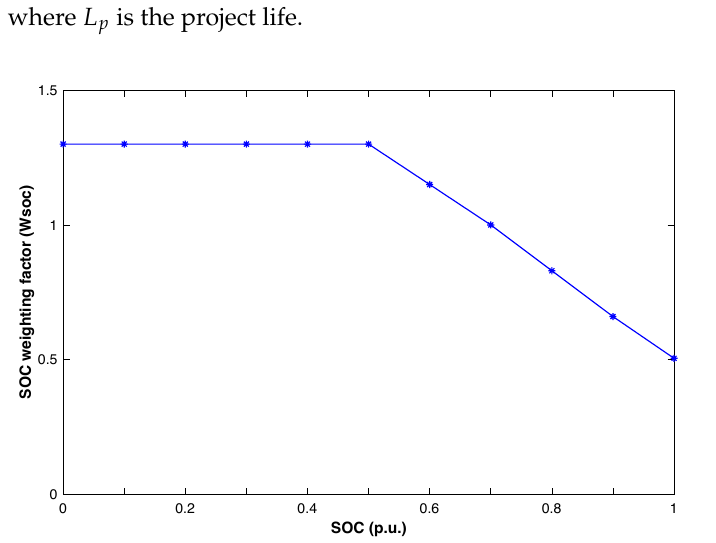
Figure 3. The relationship between SOC and the SOC weighting factor W SOC